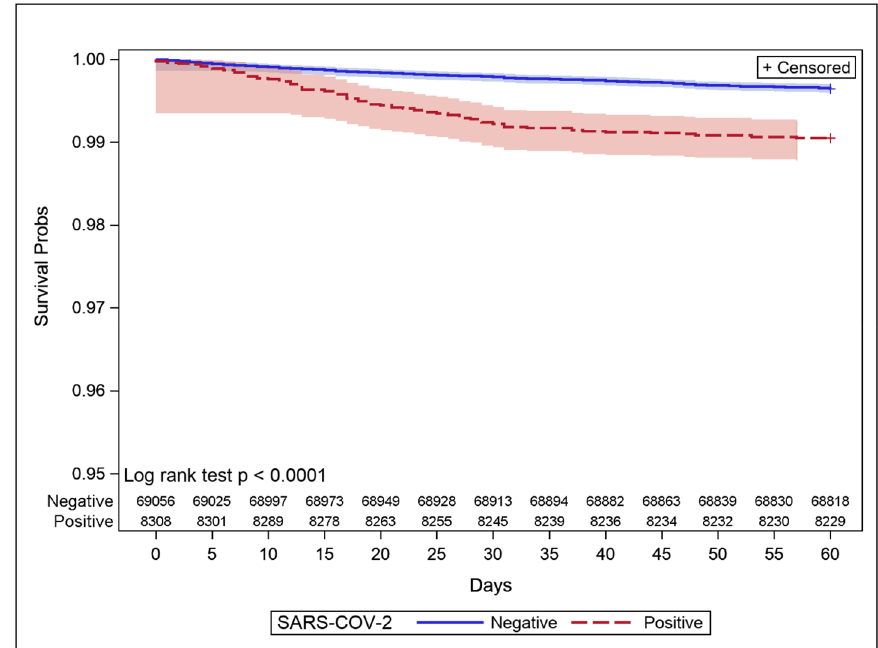
Figure 1. Time to death: Kaplan–Meier curves between SARS-CoV-2-positive and negative